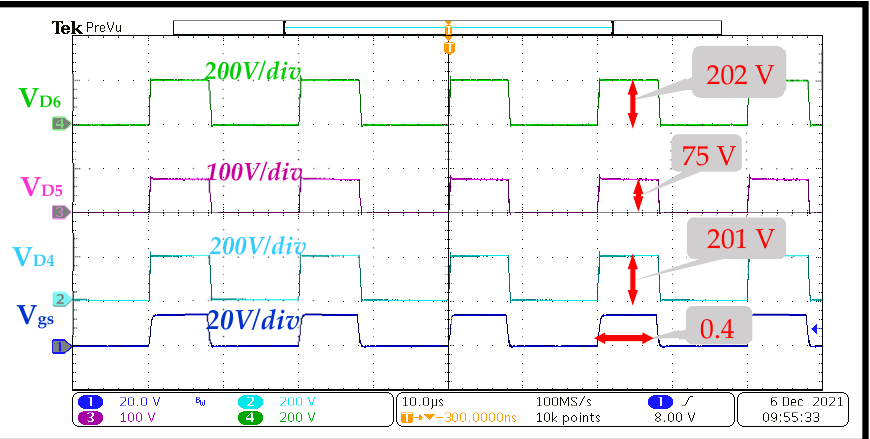
Figure 21. The experimental waveform of ( 1 ) Duty cycle (V gs ) at d = 0.4, ( 2 ) Diode (D 4 ) voltage (V D4 ), ( 3 ) Diode (D 5 ) voltage (V D5 ), and ( 4 ) Diode (D 6 ) Voltage (V D6 ).